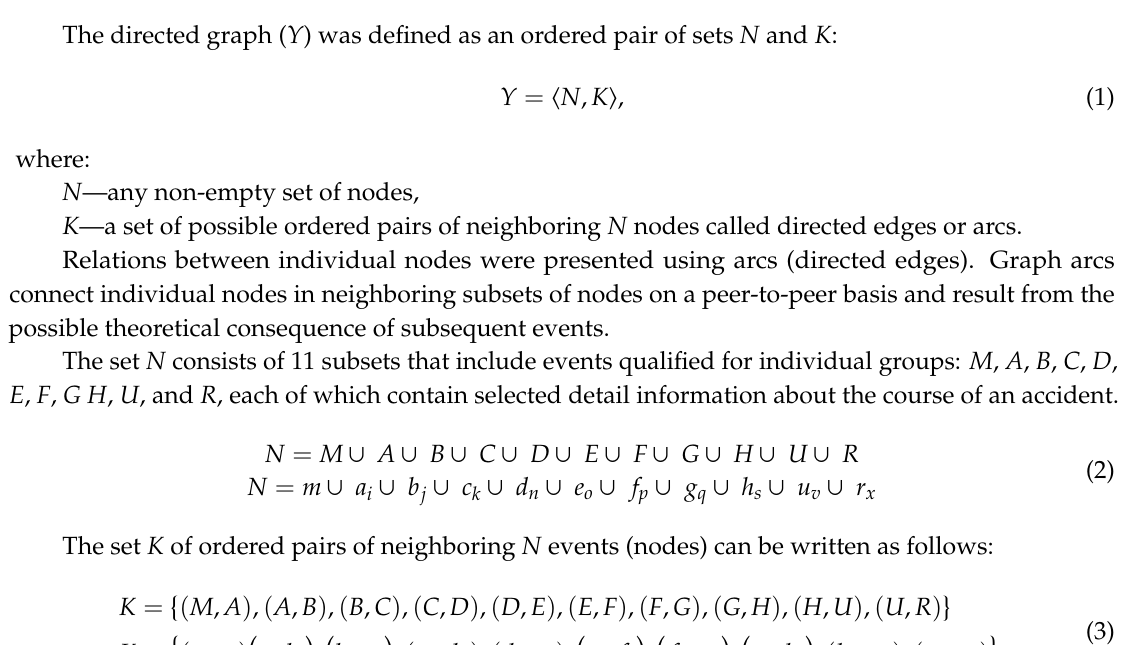
Figure 3. A model for the development of an accident situation in the construction industry (own (own elaboration).